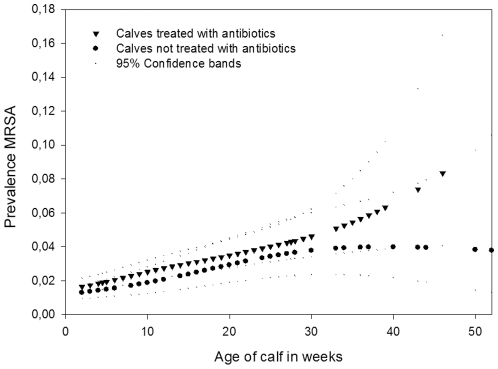
MRSA carriage in veal calves, age and antibiotic treatment.The relationship between MRSA carriage in veal calves and age for calves treated and not treated with antibiotics as group treatment (adjusted for age, number of calves per farm, farm hygiene, calf category (white versus rose veal), number of stables on farm, number of calves per pen, presence of other animals on the farm and rodent control). Smoothed plots are presented with 95% confidence bands.